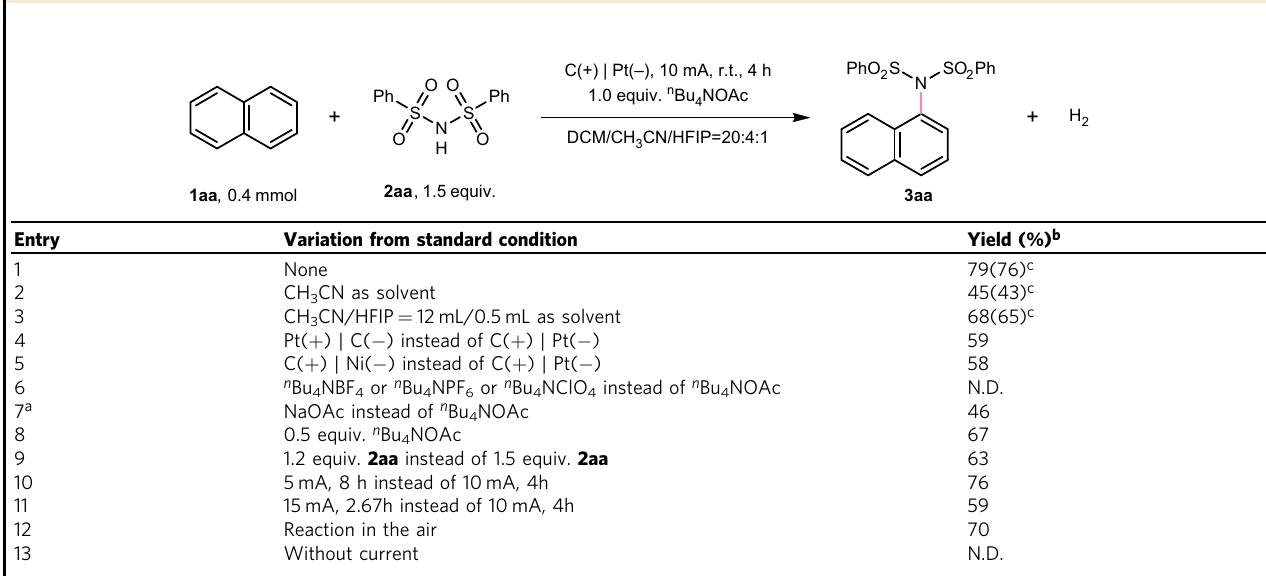
Table 1 Investigation of the reaction